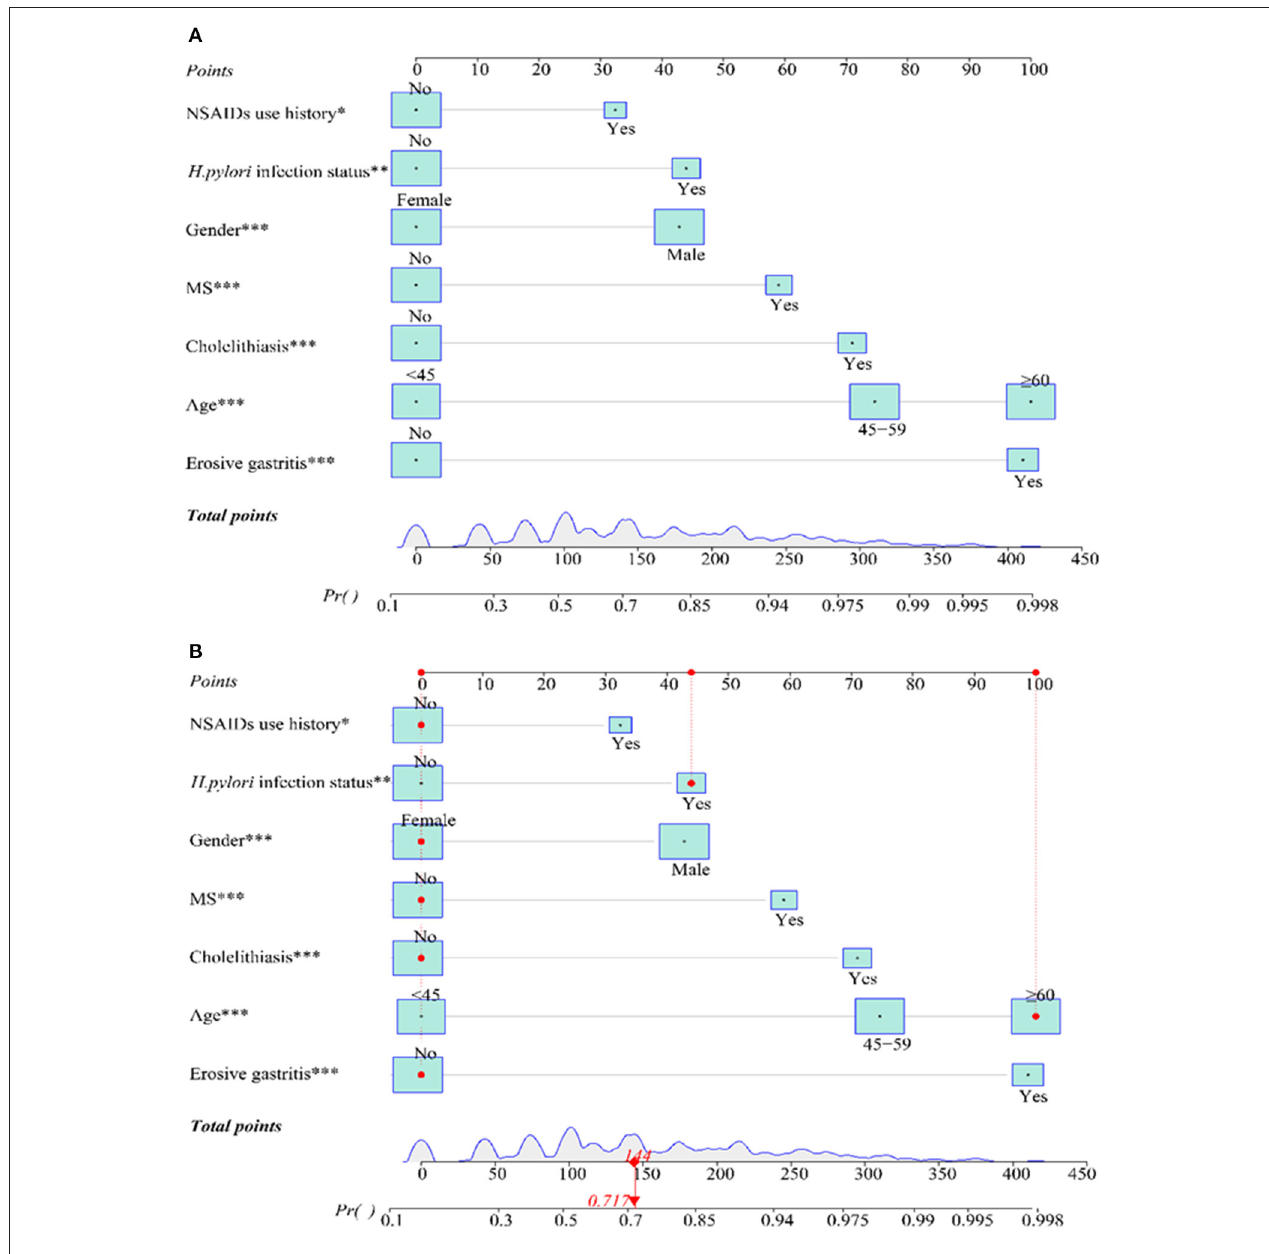
FIGURE 2 | Nomogram of prediction model (A) and model test (B)